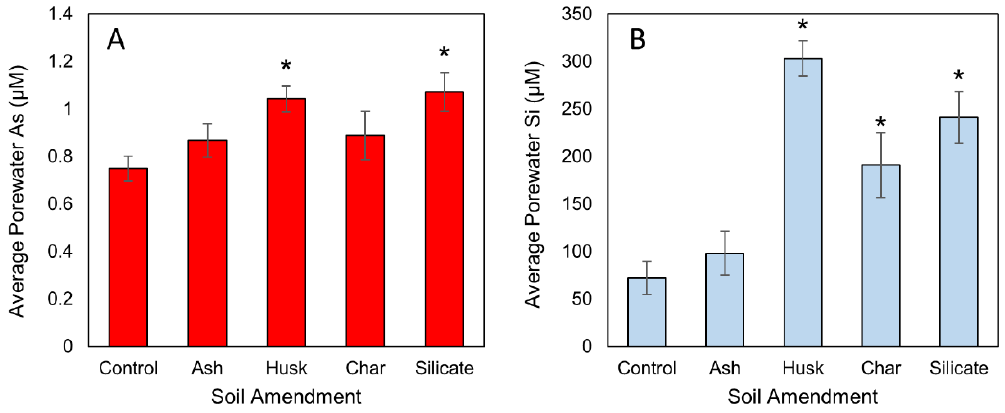
Figure 1. Impact of Si amendment on average porewater (SE) ( A ) As and ( B ) Si concentrations across all tested experiments. Asterisks denote treatment is significantly different from Control ( p < 0.05).